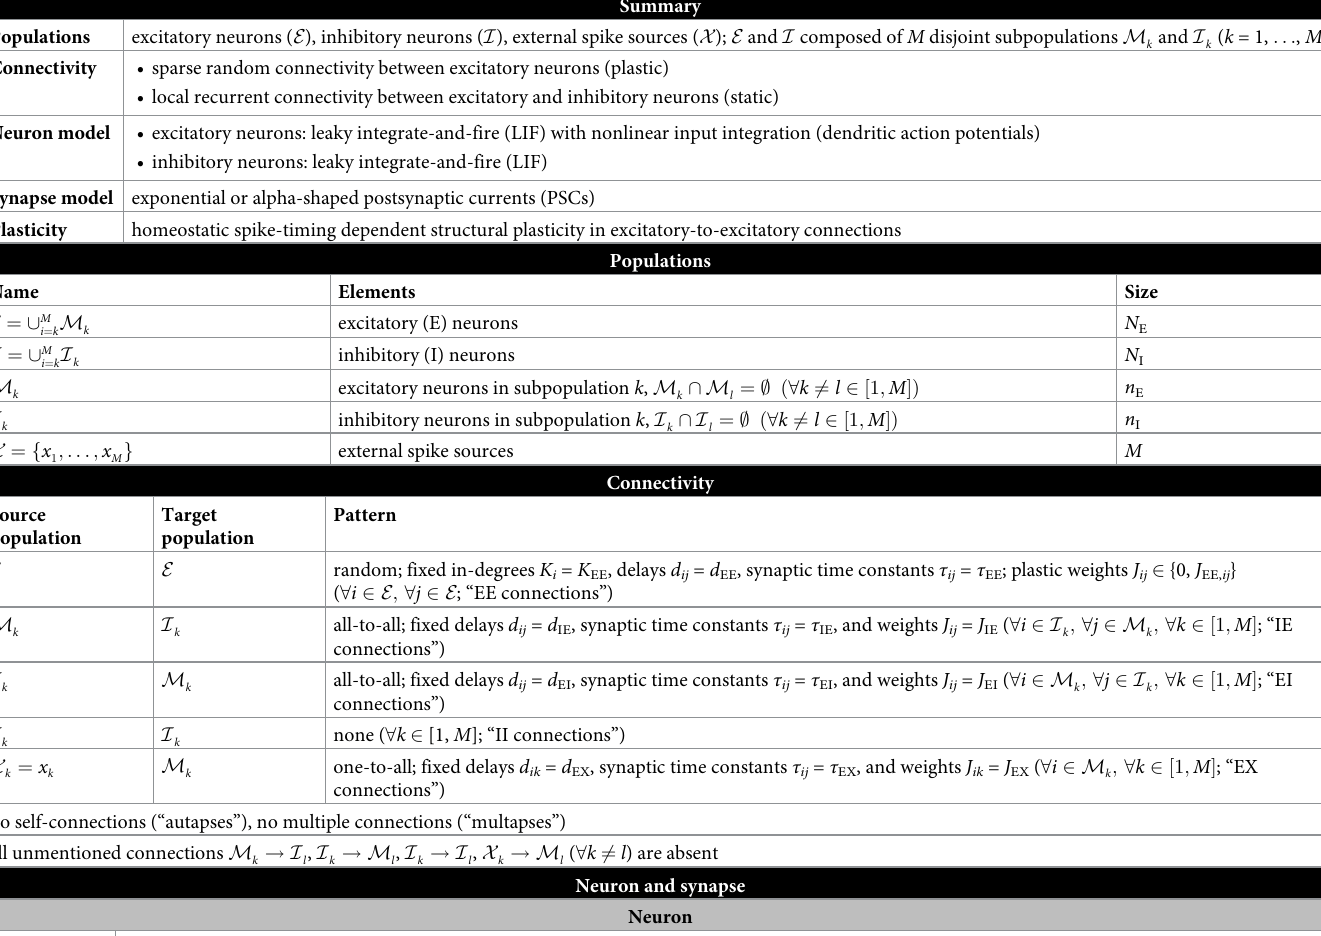
Table 1. Description of the network model. Parameter values are given in Table 2.